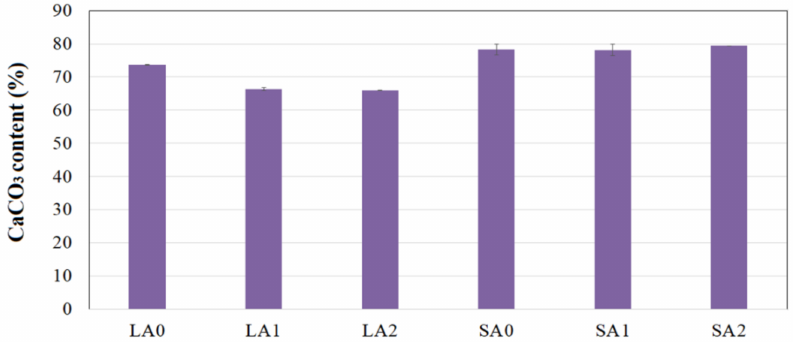
Figure 5. Calcium carbonate formation after 180 days of curing in laboratory and in the